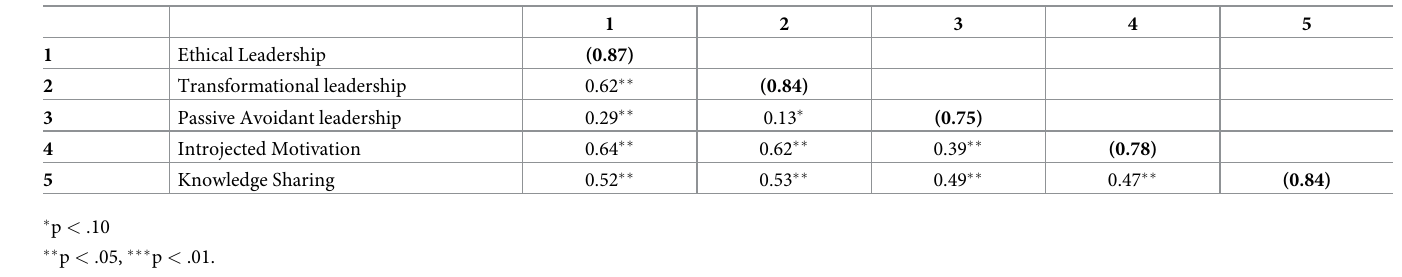
Table 2. Correlation